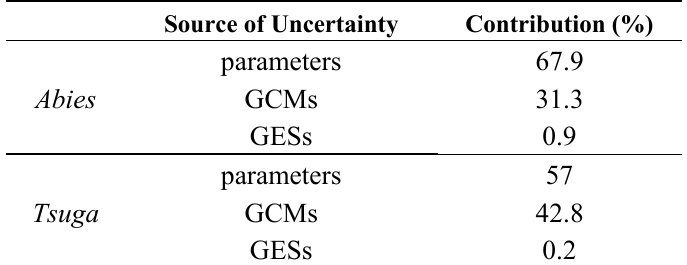
Table 2. Proportion of variability from three different uncertainty sources, including model parameters, GCMs and